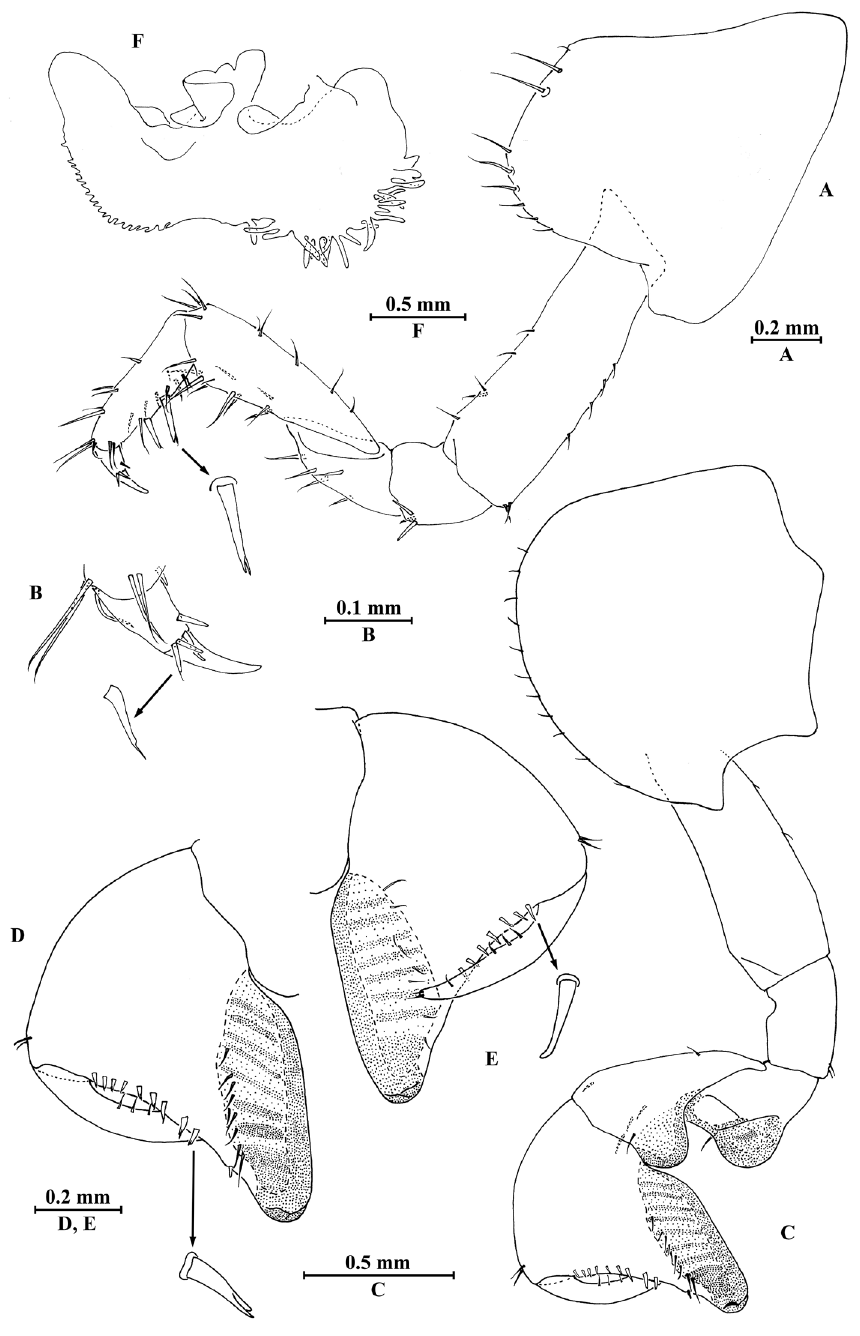
Figure 8. Myanmarorchestia seabri Hou, sp. n., male holotype. A gnathopod I B dactylus of gnathopod I C gnathopod II D propodus of gnathopod II E propodus of gnathopod II (dorsal view) F coxal gill of gnathopod II